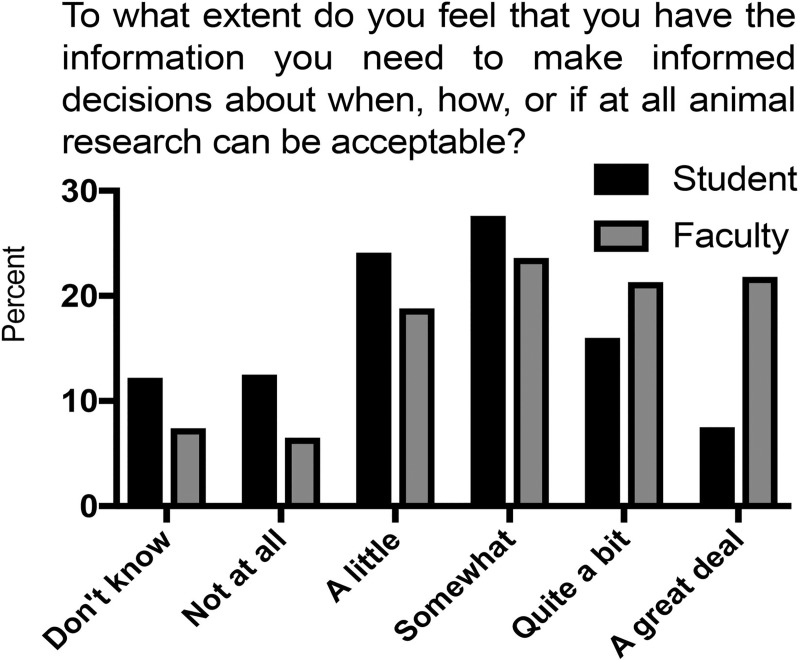
Possession of information necessary to make informed decisions about animal research.